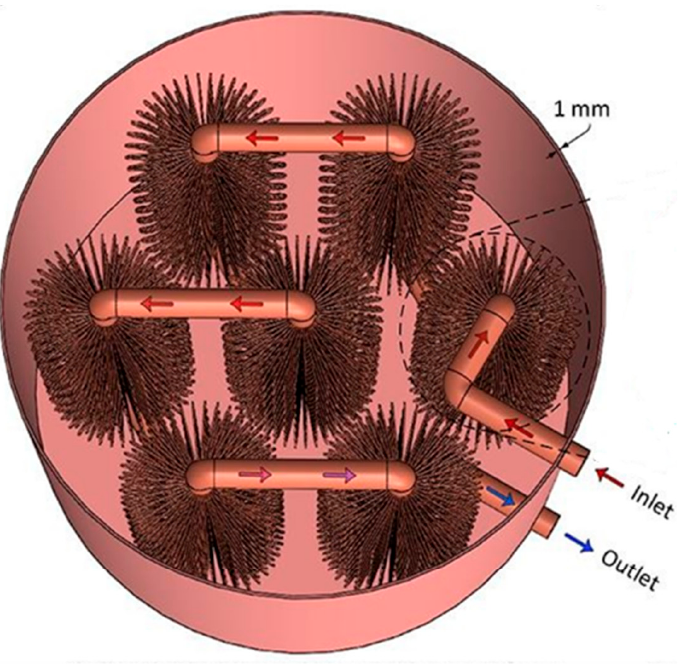
Figure 16. Wire-wound fins [125]. (Permission to reproduce from Ref.